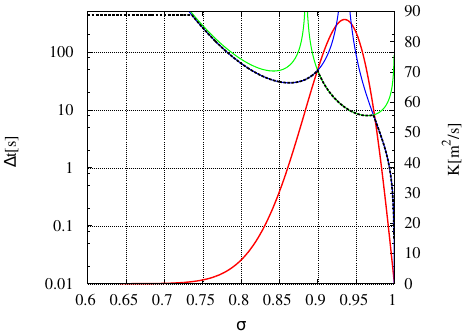
Figure 3. Average GLOBO profiles of ρ (green symbols) and φ/g Fig. 3. Average GLOBO profiles of ρ (green symbols) and φ/g (blue symbols) as a function of vertical coordinate σ , and their ana- (blue symbols) as a function of vertical coordinate σ and their ana- lytical fits (Eq. 23 and Eq. 24, lines of the same colors). lytical fits (Eqs. 23 and 24). of the full 3-D model. Input profiles were obtained by run- Table 1. RMSE and execution time for different C T ning the low-resolution version of GLOBO (horizontal grid of 362 242 cells and 50 vertical levels evenly spaced in σ ) 405 × starting at 2011-03-11 00:00 UTC. After 36 hours of simula- tion (12:00 UTC), averages on σ = const surfaces were per- formed for K , ρ and Φ , obtaining vertical profiles as a func- tion of σ . Fields of ρ and Φ were averaged over the whole domain. As far as K is concerned, averages were performed 410 for latitude between +60 ◦ and -60 ◦ North in daytime (longi- tude between -45 ◦ and +45 ◦ East) and nighttime (longitude between +135 ◦ and -135 ◦ East) conditions, over land and sea separately. The most intense K profile is selected, which corresponds to the daytime conditions over land. Profiles of 415 ρ and z are rather smooth and regular over space and time, while K displays a large variability. The profiles were fitted